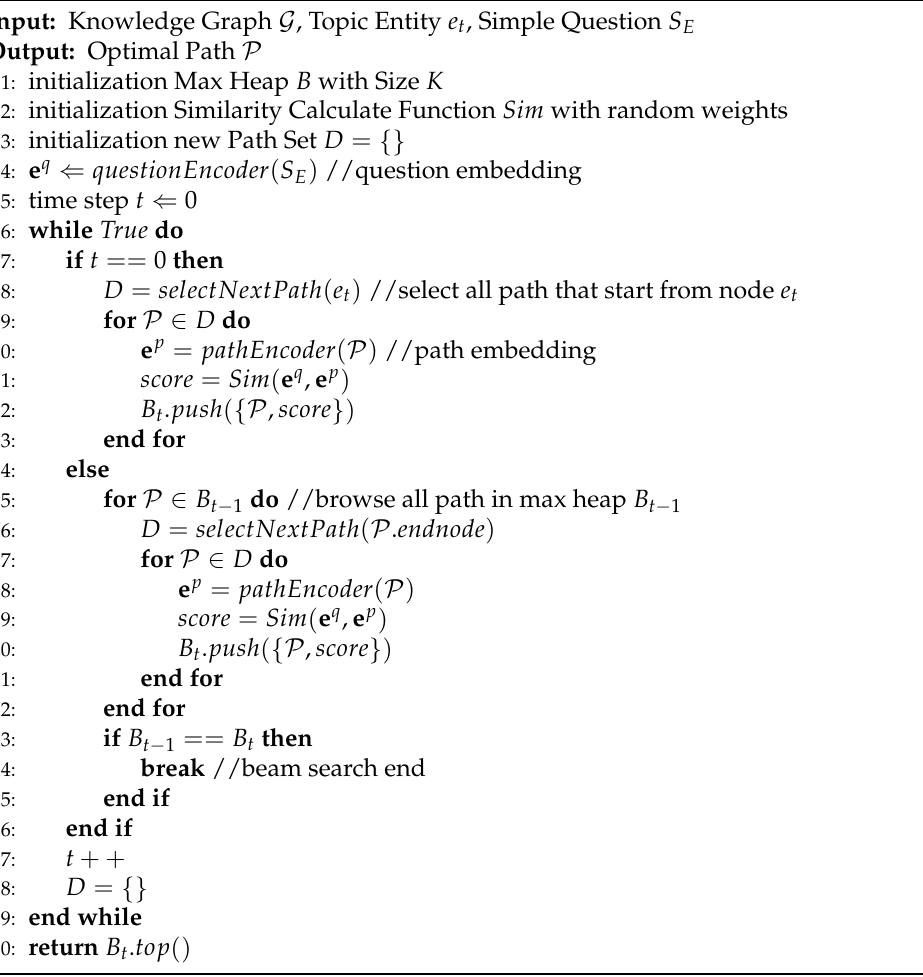
Algorithm 1 the process of